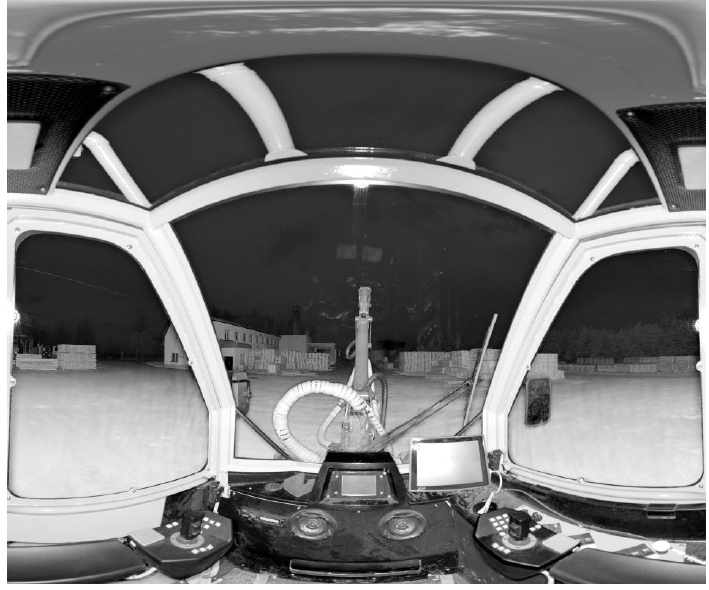
Figure 2. Driver’s field of vision from harvester Model H50 Strojírna Novotný, Vitošov, Czech Republic (photo from scanner).